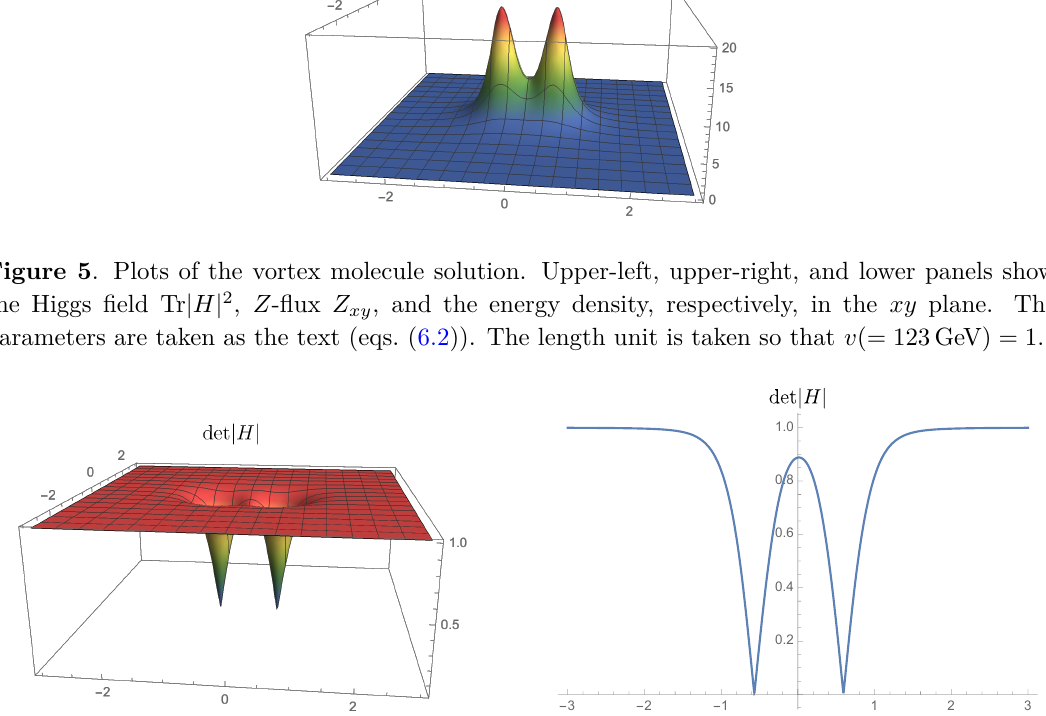
that the configuration contains the Z flux as in the case of the non-topological Z